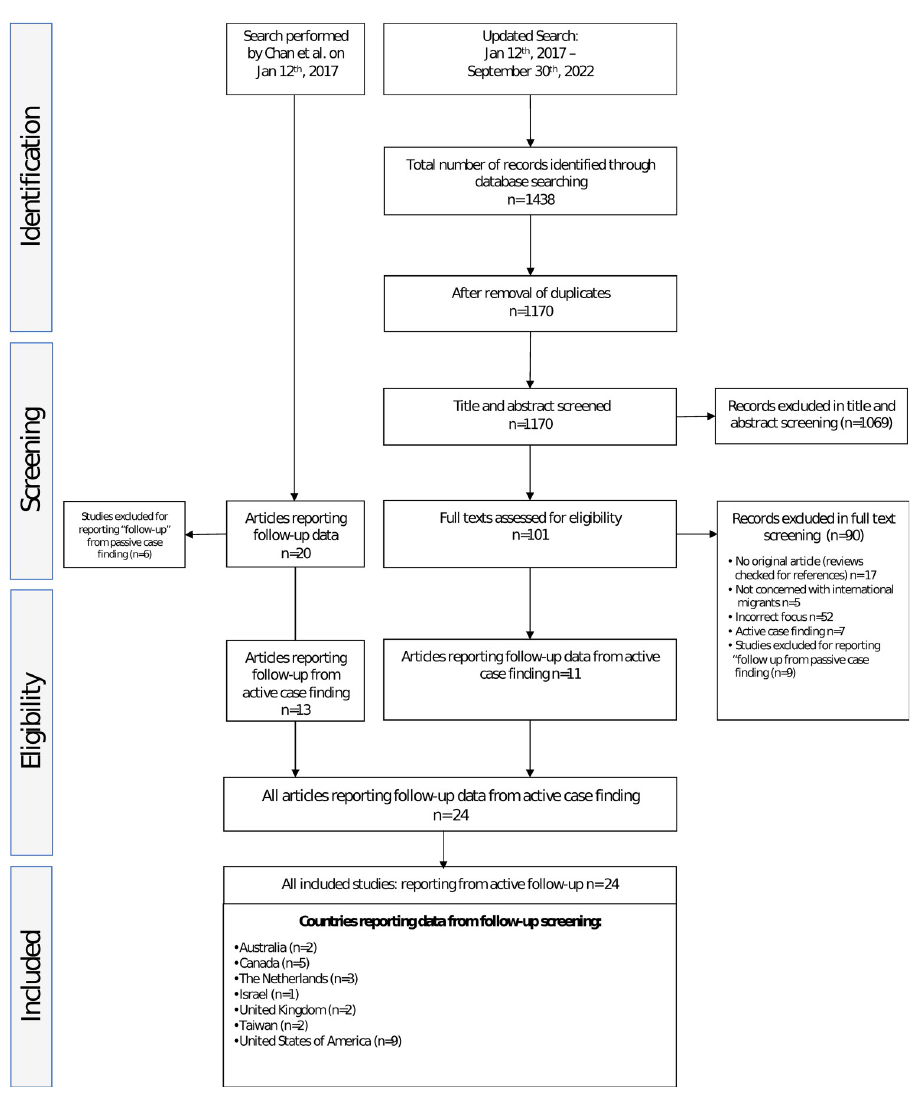
Fig 1. Prisma flow